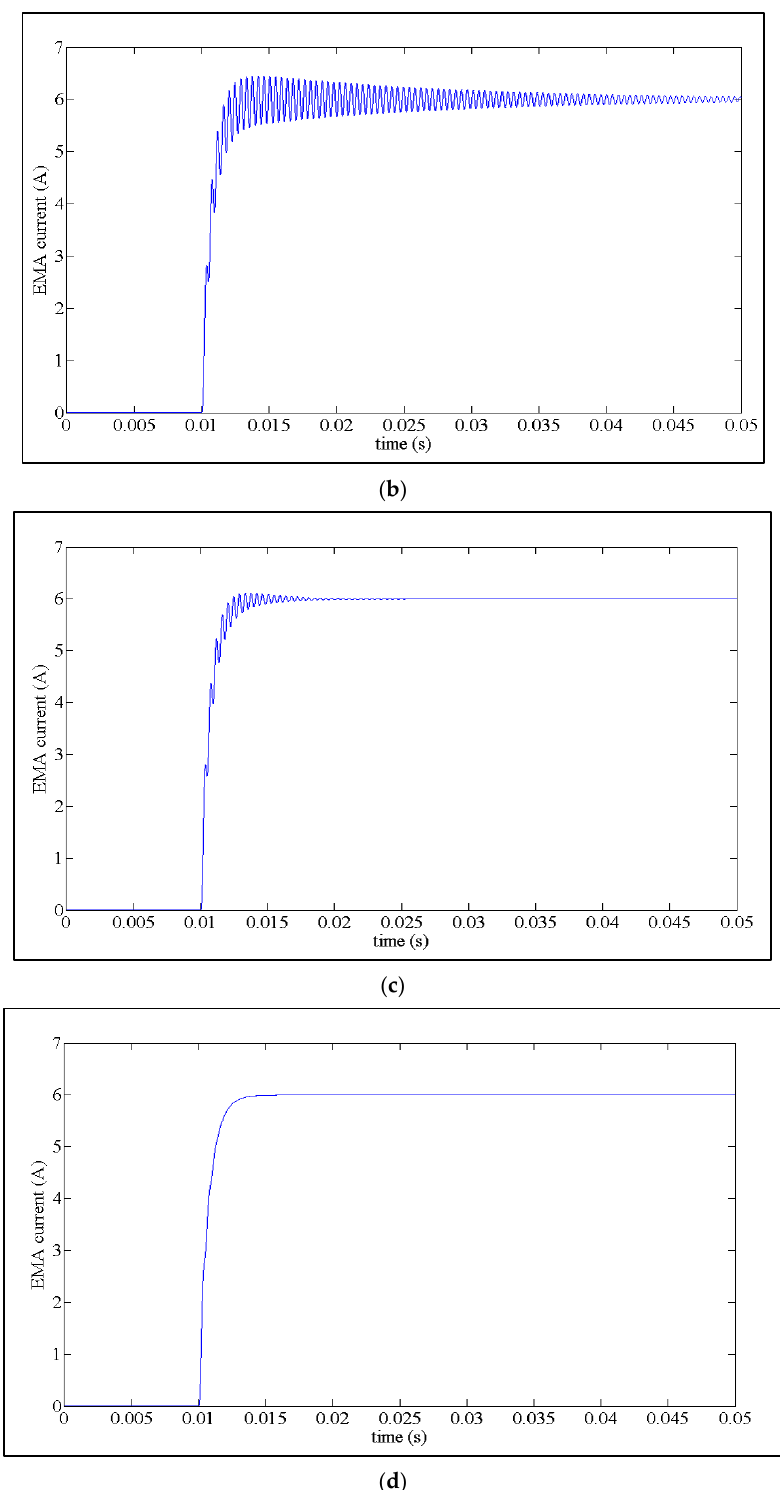
Figure 6. Step response of the closed-loop system for ( a ) 𝑟 = 0.04 Ω , ( b ) 𝑟 = 0.06 Ω , ( c ) 𝑟 = 0.09 Ω , and ( d ) 𝑟 = 0.3 Ω .